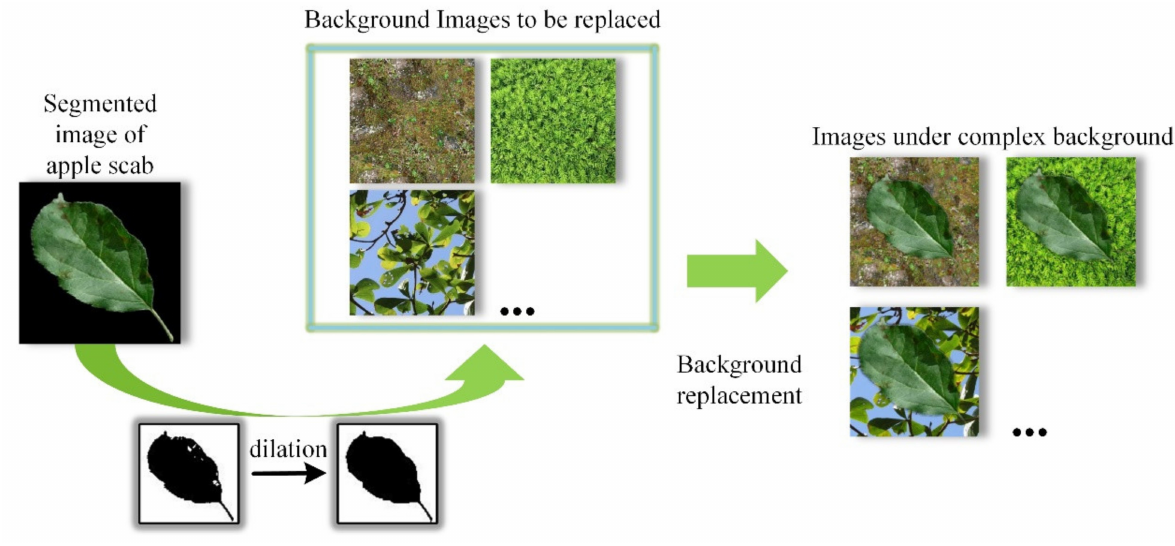
Figure 4. The process of background